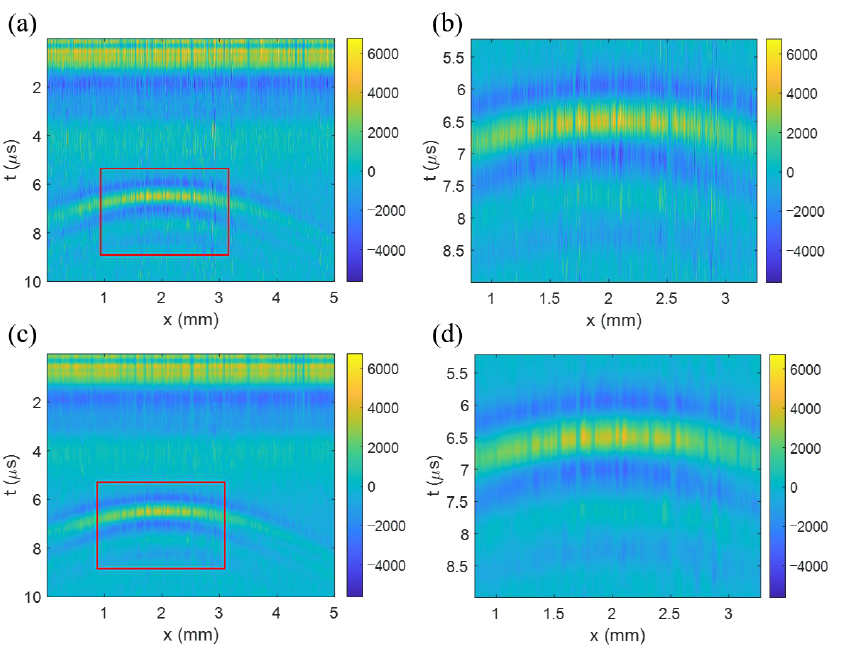
Figure 8. Experimentally acquired B-scan image of a PDMS block specimen. ( a ) Original image, ( b ) the enlarged image, ( c ) filtered image, and ( d ) the enlarged image. Gaussian filtering was used to remove the line shape noises in the vertical direction.